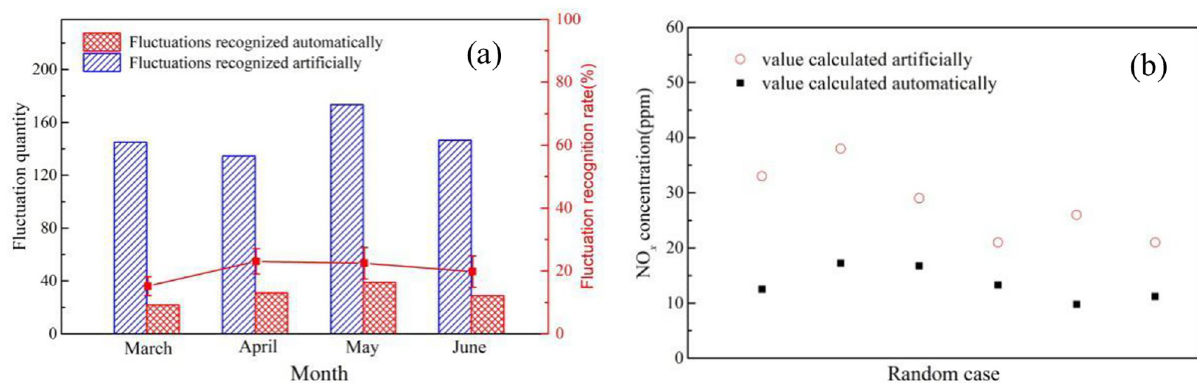
Fig 7. Comparison of (a) quantity of fluctuations recognized automatically and artificially; (b)NO x concentration value calculated artificially and automatically.